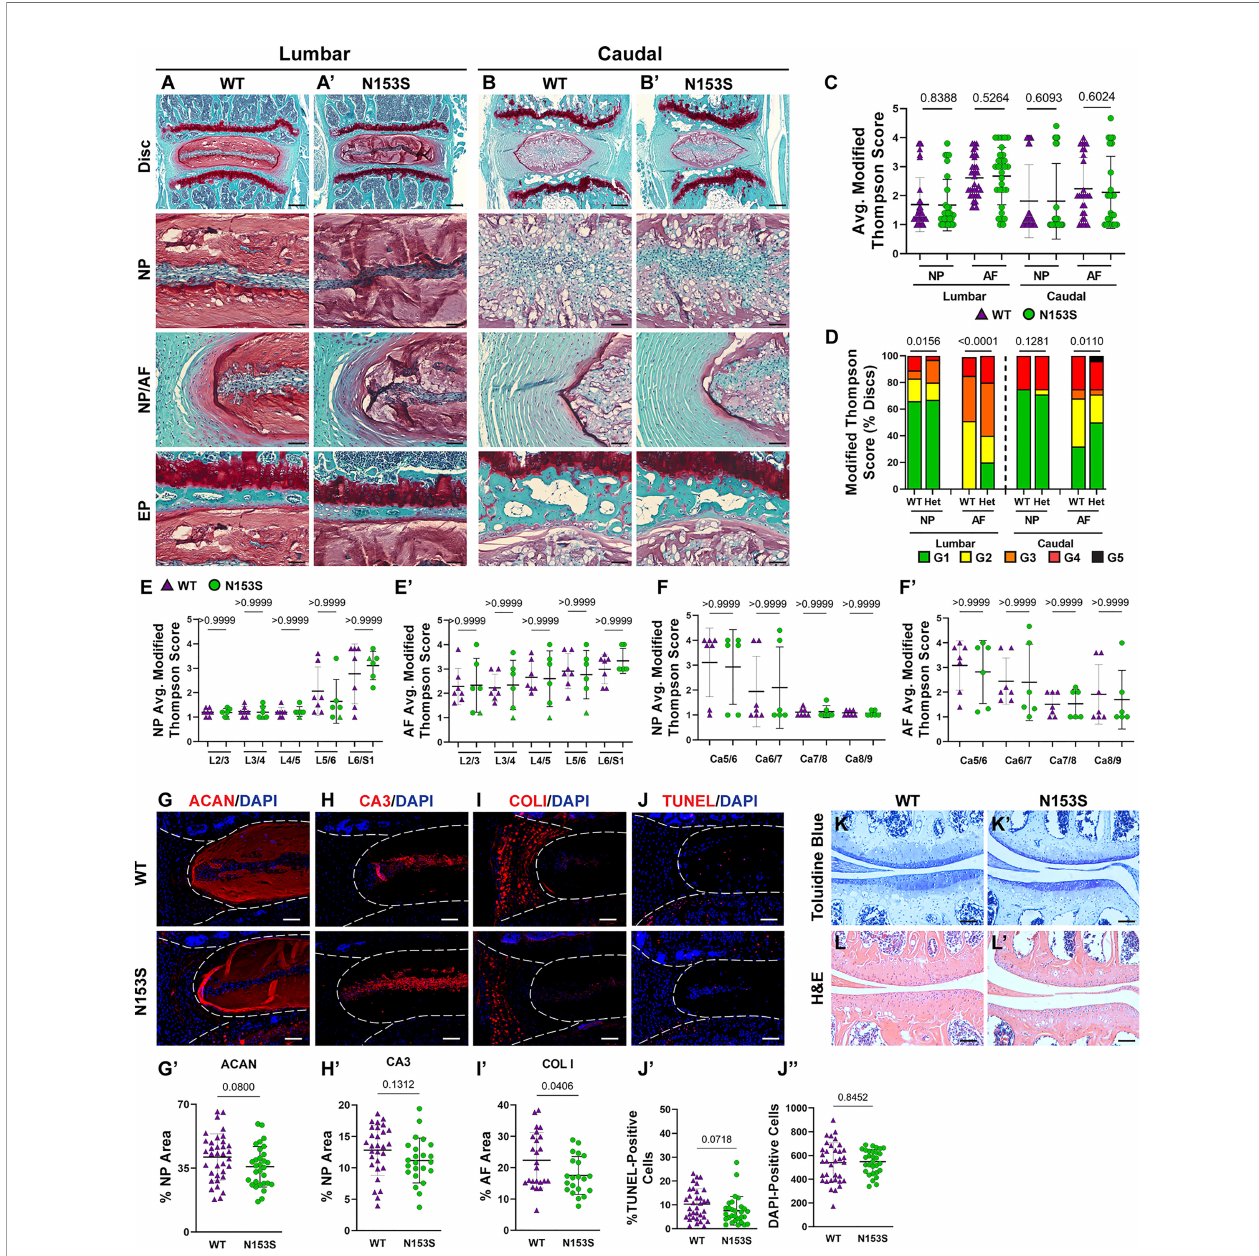
FIGURE 4 | Intervertebral discs and articular cartilage of N153S mice do not evidence accelerated degeneration. (A-B ’ ) 6-month-old WT and N153S mice were analyzed and Safranin O/Fast Green staining of (A, A ’ ) lumbar and (B, B ’ ) caudal discs shows tissue morphology and proteoglycan content (row 1, scale bar= 200 m m) and high magni fi cation images of the NP, EP, and NP/AF tissue boundary (rows 2-4, scale bar= 50 m m) are shown. N153S discs retain vacuolated cells in the NP, demarcation between tissue compartments, and tissue architecture. (C-F ’ ) Histological grading assessment using the modi fi ed Thompson scale for (E, E ’ ) lumbar and (F, F ’ ) caudal discs (n = 5 lumbar discs/animal, 4 caudal discs/animal, 7 animals/genotype, 35 lumbar and 28 caudal discs/genotype). (C) average and (D) distribution of histological grades in the NP and AF, with higher scores indicating higher levels of degeneration. (E, F ’ ) Level-by-level average grades of NP and AF degeneration. (G-I ’ ) Quantitative immunohistological staining conducted on lumbar discs for: (G) aggrecan (ACAN), (H) carbonic anhydrase 3 (CA3), and (I) collagen I (COL I). (G ’ -I ’ ) Staining quanti fi cation demonstrating no change in ACAN and CA3 abundance and a slight reduction in COL I. (J-J ” ) TUNEL staining showing apoptotic cells in the NP and AF regions of lumbar intervertebral disc sections from WT and N153S mice. (H, I) Corresponding quanti fi cation showing the percentage of TUNEL-positive cells and the number of DAPI-stained nuclei in the entire disc compartment. (K, K ’ ) Toluidine blue staining in the medial femoral condyle and tibial plateau shows no alteration to proteoglycan content and cartilage damage/loss. (L, L ’ ) H&E hindlimb staining showing no apparent cell death or osteophyte formation. (G-L ’ scale bar=100 m m) (n = 4 discs/animal, 7 animals/genotype, 28 total discs/genotype) (n = 1 joint/animal, 3 animals/genotype, 3 joints/ genotype) Signi fi cance for grading distribution was determined using a c 2 test. Signi fi cance of average and level-by-level grading and immunohistochemistry was determined using an unpaired t-test or Mann-Whitney test, as appropriate. Quantitative measurements represent mean ±